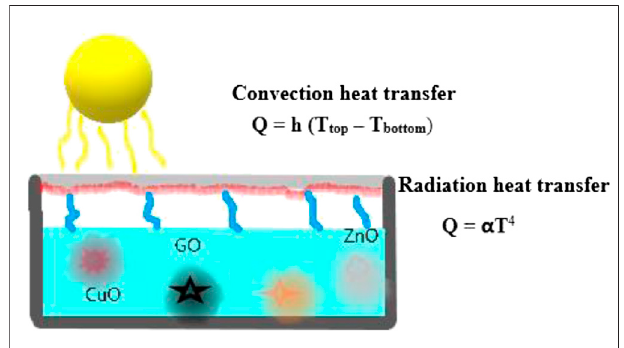
FIGURE 9 | Heat transfer phenomenon in direct solar